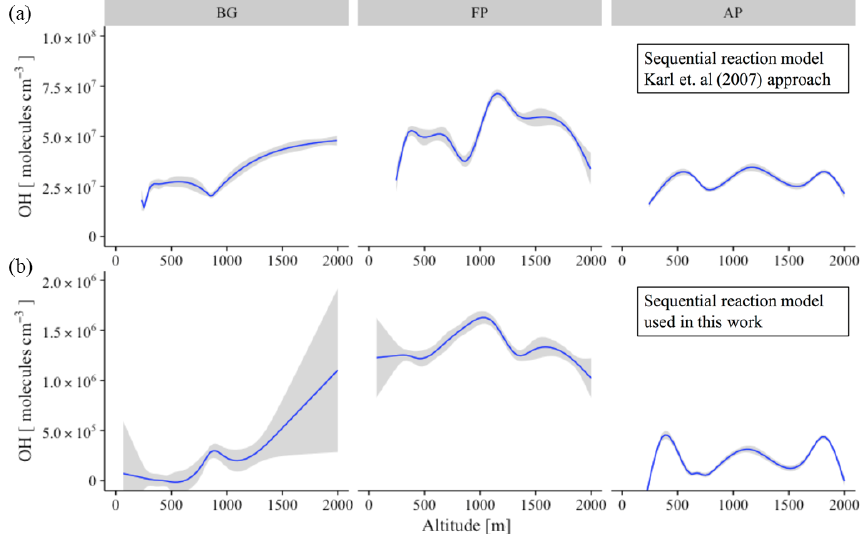
Figure 9. Vertical profile of OH concentration (moleculescm − 3 ) for the different chemical regimes: background environment (BG), fresh smoke plume (FP), and aged smoke plume (AP). (a) The sequential reaction model according to the original approach of Karl et al. (2007), and (b) , the new approach used in this work. Blue lines are the trend lines and gray intervals represents the level of confidence (0.95)